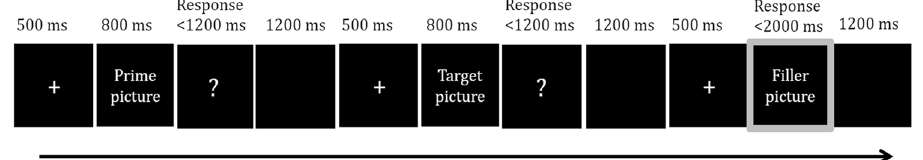
Figure 2. Procedure of the experimental trial and the filler trial. In the experimental trials, the prime picture and the target picture were presented alone sequentially. In the filler trials, the picture was presented together with a gray frame. Participants were required to withhold their naming responses until the onset of a question mark when the picture was presented alone, and to name the picture immediately when the picture was accompanied with a gray